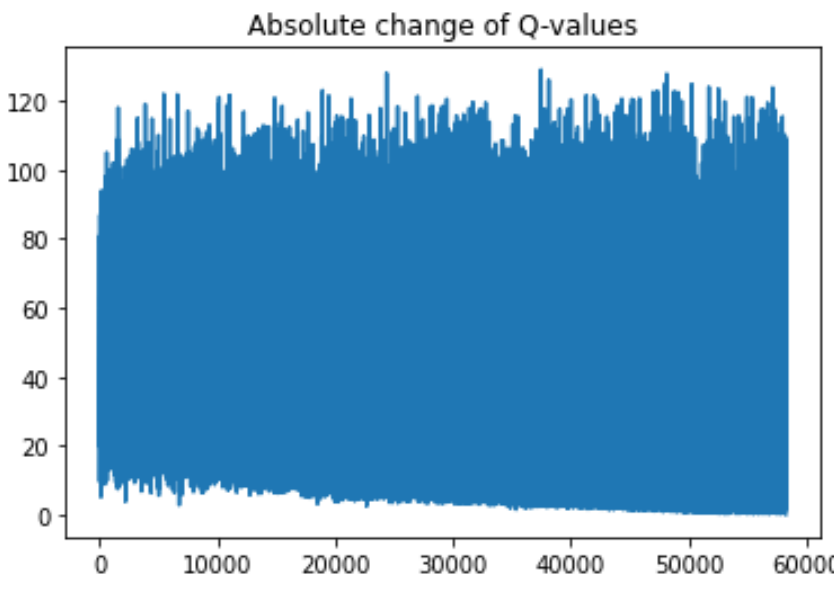
Figure 16. Change of Q